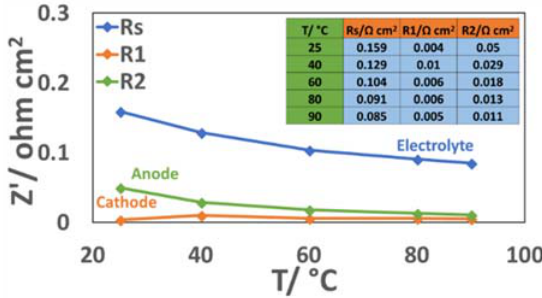
Figure 10. Variation of relevant electrochemical parameters at 1.8 V as a function of temperature for the low catalyst loading-based MEA. Rs refers to the series resistance; R1 and R2 refer to the high and low frequency relaxation processes, respectively.